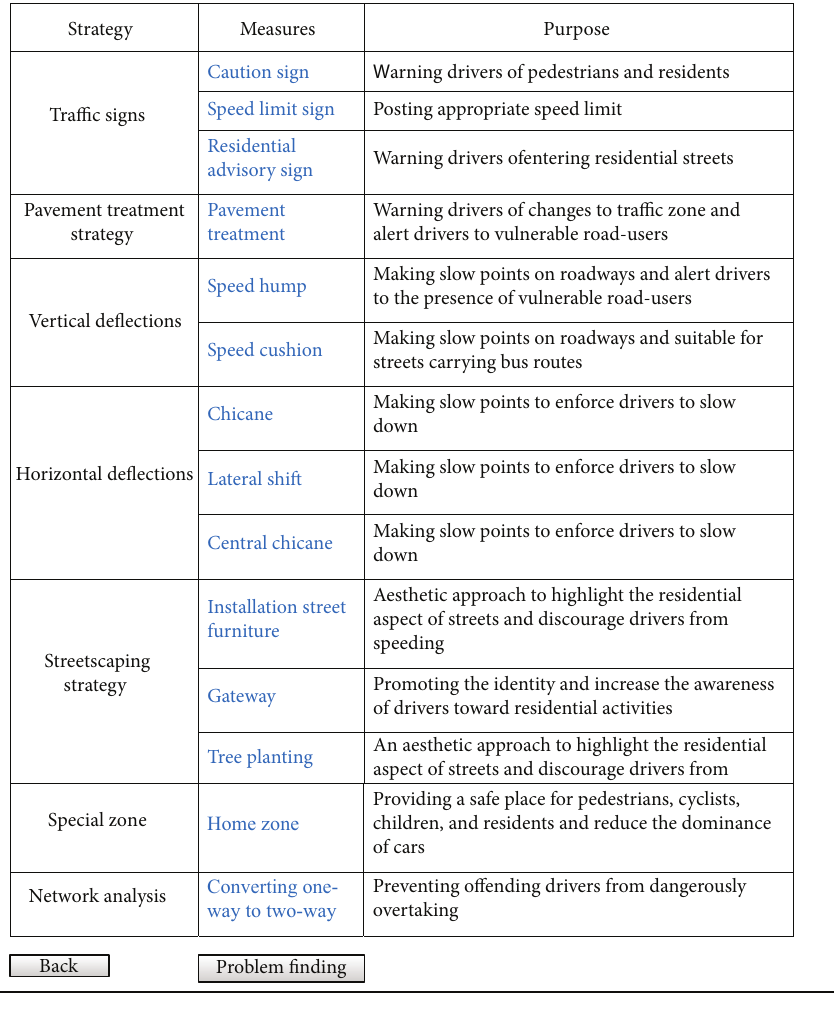
Figure 8: A screenshot of the solutions for speeding